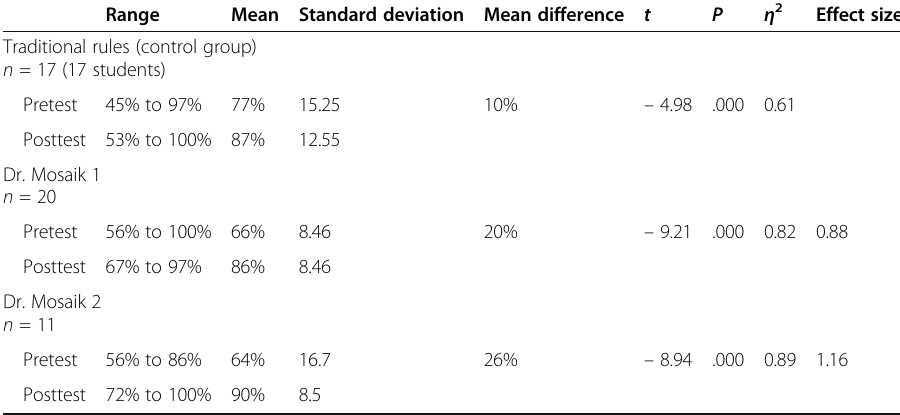
Table 4 Pre- and posttest results and related statistical data